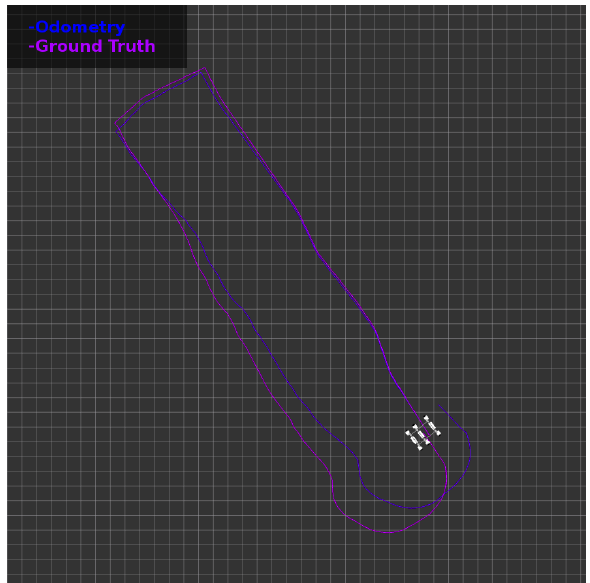
Figure 8: Path calculated from estimated robot velocity based on motor feedback together with the path recorded using RTK-GNSS. The robot model is to scale and the grid is 1 m x 1 m.